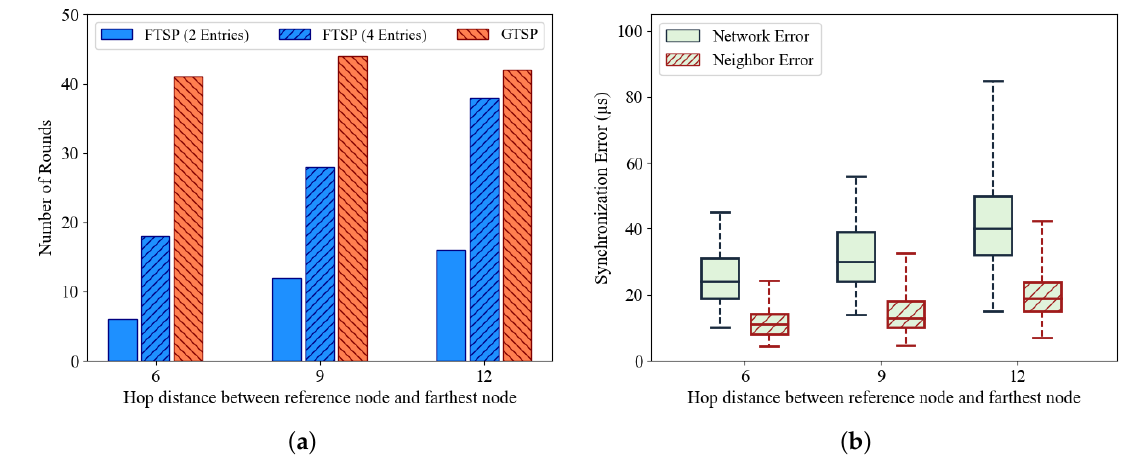
Figure 10. ( a ) Number or rounds required to synchronize entire network with different hop distances between reference node and farthest node. ( b ) Synchronization error of FTSP with different hop distances between reference node and farthest